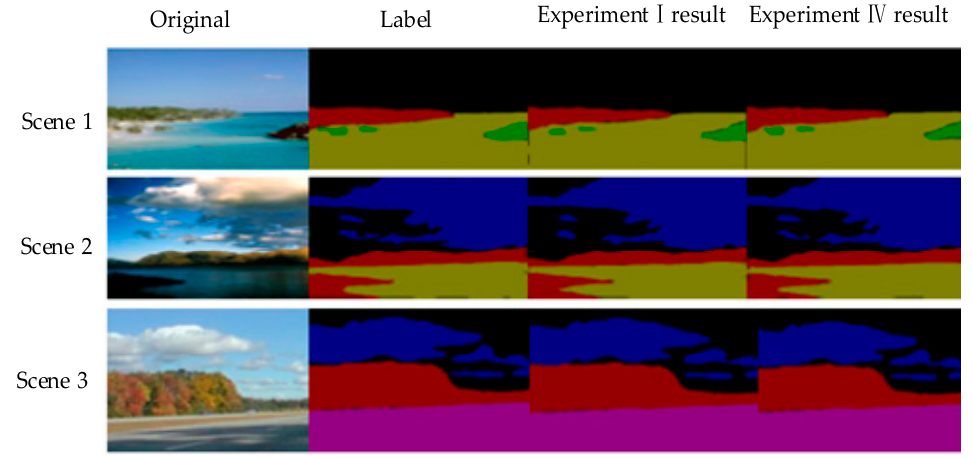
Figure 19. Images of Experiment I and Experiment IV on the SIFT Flow dataset.